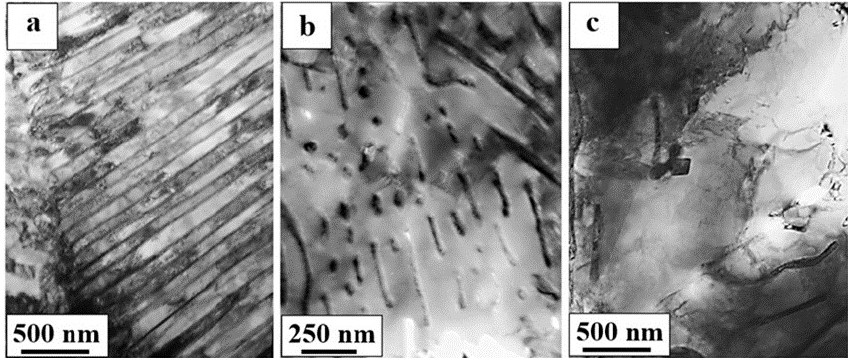
Figure 3. Electron microscopic images of rail structure in the layer located at a depth of 10 mm; a – lamellar pearlite; b - degenerate pearlite; c – structure-free ferrite.